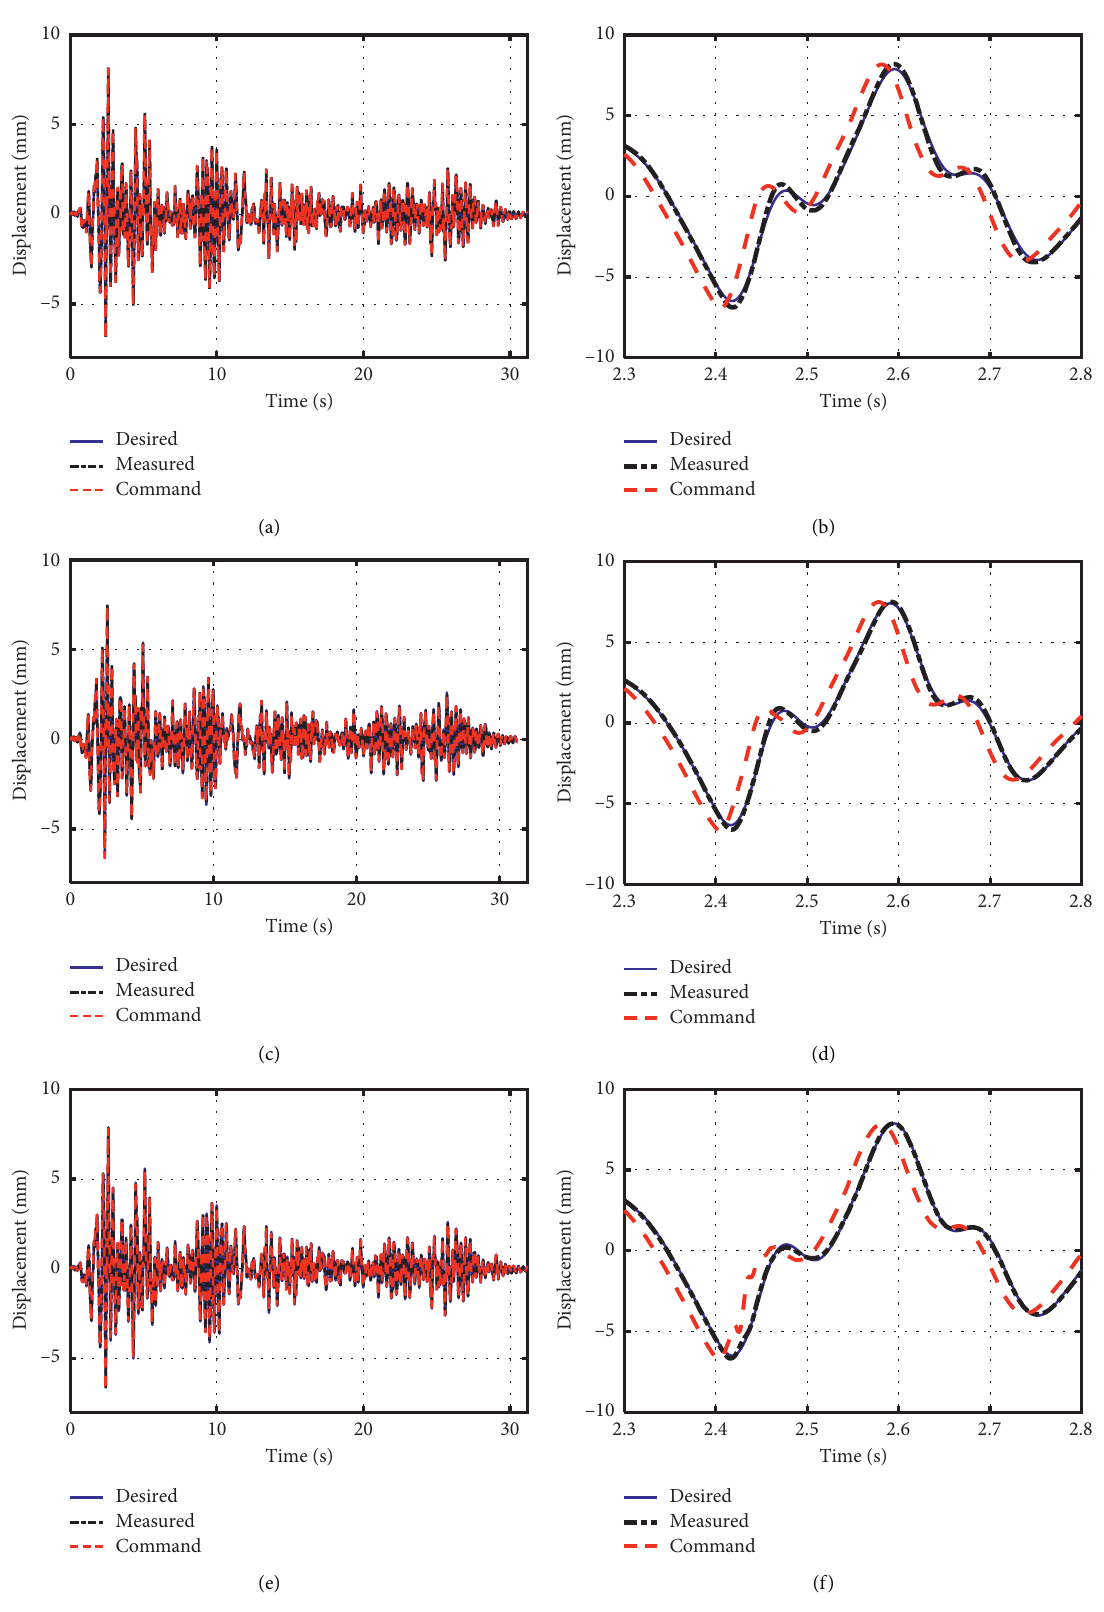
Figure 12: Displacement time histories obtained in RTHS with seismic excitation. (a) Displacements obtained with the PE method. (b) Enlarged view of (a). (c) Displacements obtained with the SADC method. (e) Displacements obtained with the TADC method. (f) Enlarged view of